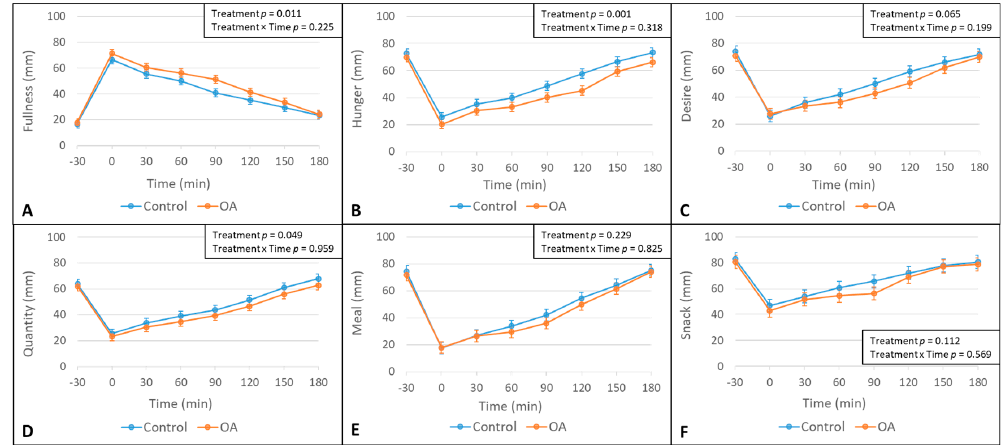
Figure 3. Means and SE (Standard Error) bars for self-reported appetite ratings in participants ( n = 31) prior to and following mouth rinse treatments over time. Means, SE bars, and p ‐ values were estimated by using a linear mixed model including treatment, time, and treatment × time interaction as fixed effects; the participant was used as a mixed effect to control for duplicate measures of each treatment ( A ): fullness ratings; ( B ): hunger ratings; ( C ): desire to eat ratings; ( D ): quantity of food that could be consumed ratings; ( E ): desire to eat a meal ratings; and ( F ): desire to eat a snack ratings.